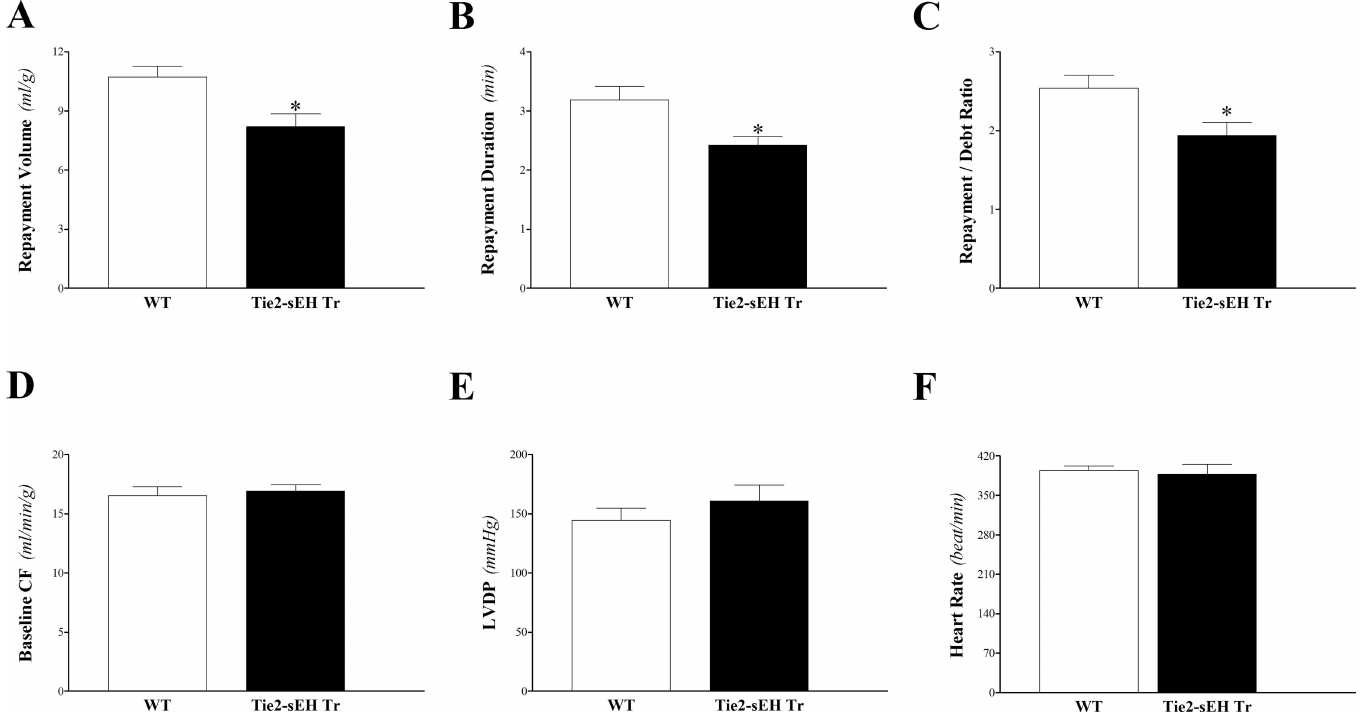
Fig 1. Comparison of coronary reactivehyperemia (CRH) between Tie2-sEH Tr and WT. Repaymentvolume (A), repayment duration(B), and repayment/debt ratio (C), were increasedin Tie2-sEH Tr comparedto WT mice ( P < 0.05). BaselineCF (D), LVPD (E), and HR (F) were not different between the two groups. * P < 0.05 versus WT. n = 12 per group.